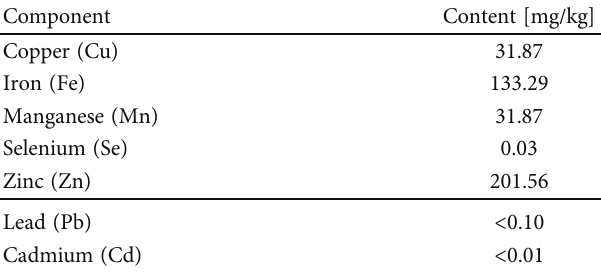
Table 4: Selected microelements and heavy metal contents of deproteinized ethanol-treated sun fl ower